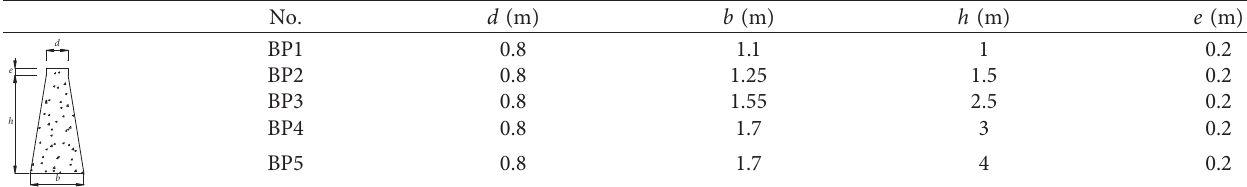
Table 3: Geometric dimensions of in situ test